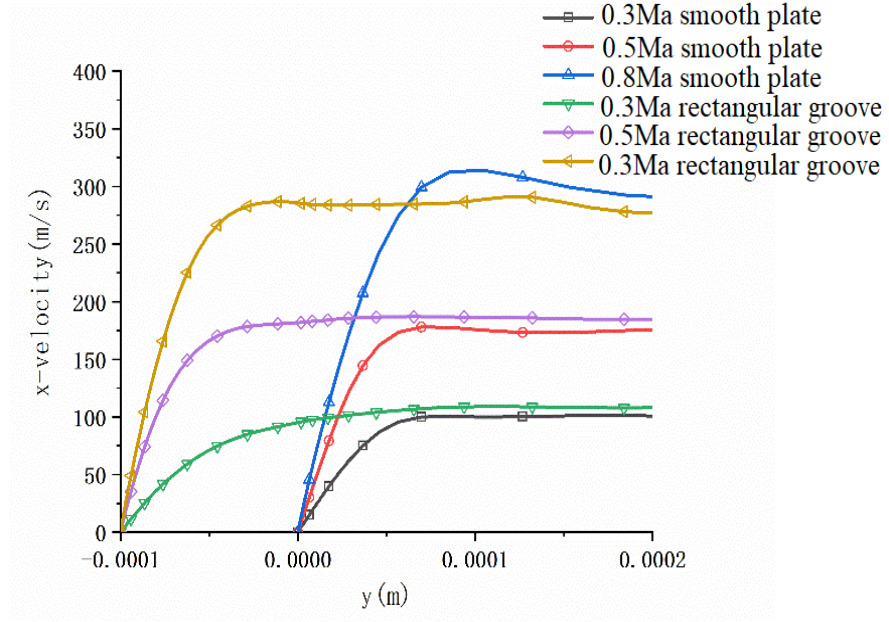
Figure 23. Velocity profiles of rectangular groove and smooth plate under different Mach numbers.